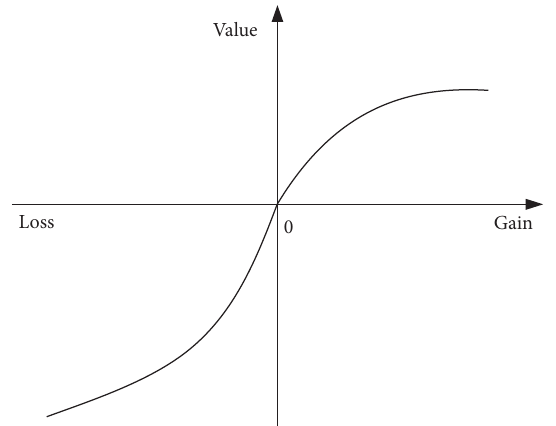
Figure 1: Value function of prospect theory.